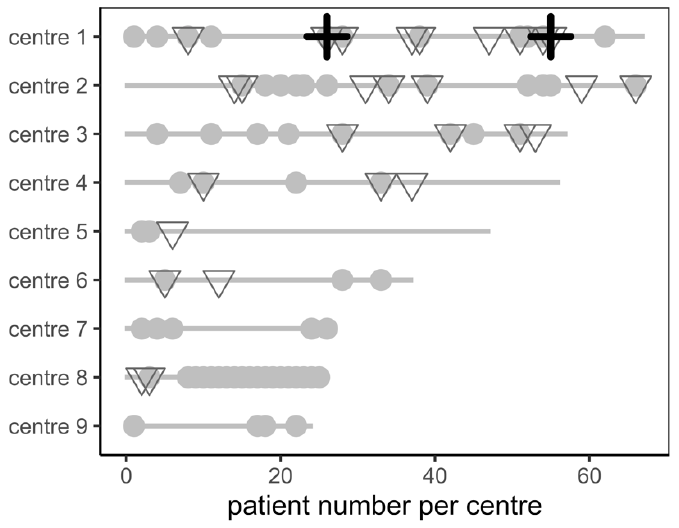
Figure 1. Patient count, minor complications (grey dot), major complications (grey triangle), and periprocedural mortality (black cross) stratified by centre.